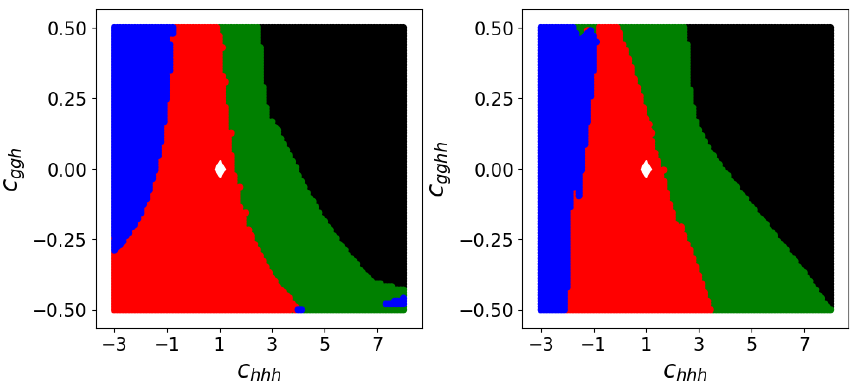
Figure 5 . The parameter regions associated to each shape type in the c hhh (cid:0) c ggh (left) and c hhh (cid:0) c gghh (right) planes.